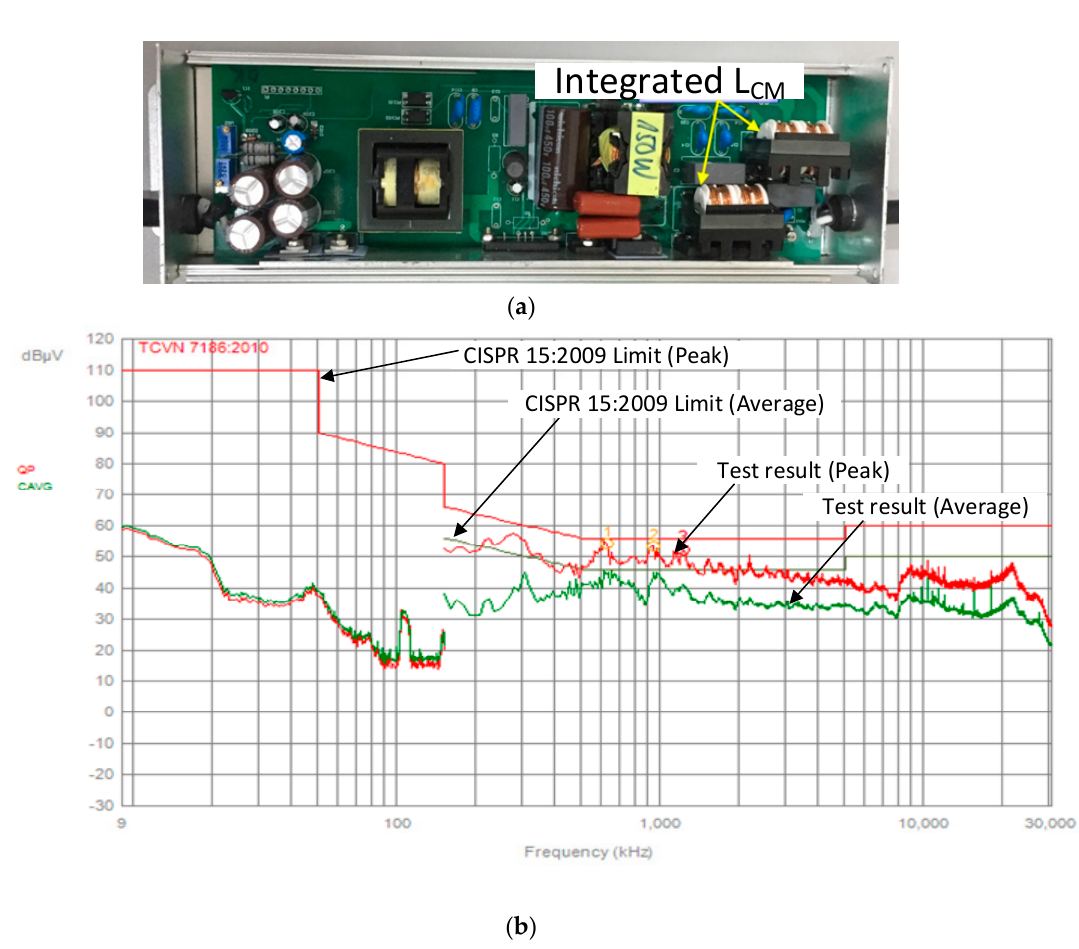
Figure 17. ( a ) The 150 W ‐ based two ‐ stage LED driver with combined L CM and L DM . ( b ) EMI frequency spectrum.